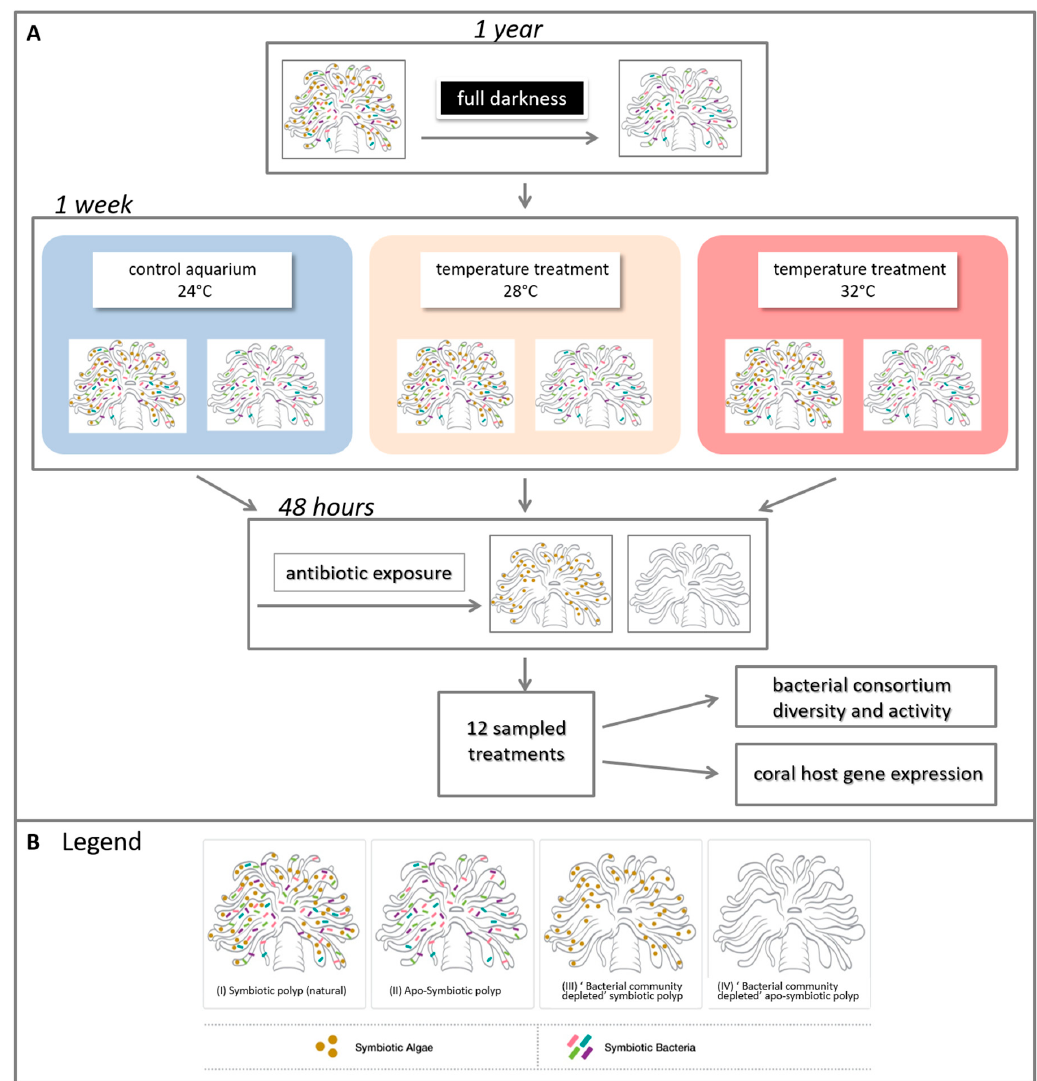
Figure 1. Experimental design. ( A ) Experiment layout and ( B ) legend of four generated symbiotic states. Four adult colonies of Euphyllia paradivisa were collected from 40–60 m depth from the Gulf of Eilat and fragmented. Half of the fragments were kept in darkness for a year to generate a full apo ‐ symbiotic